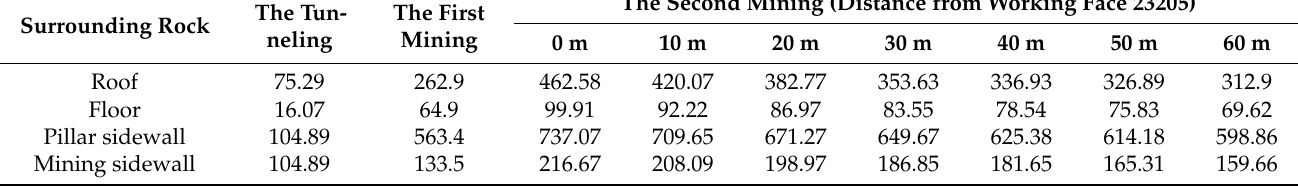
Table 2. Deformation of the roadway-surrounding rock under different engineering disturbance (unit: